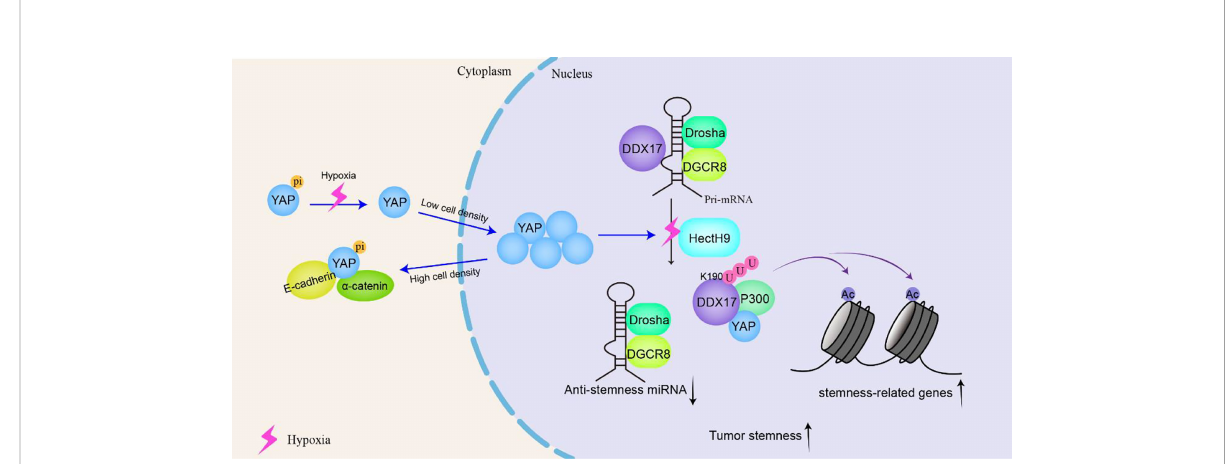
FIGURE 6 DDX17 participates in the YAP signaling pathway to increase the stemness of cancer stem-like cells and to promote tumorigenesis and tumor progression. In tumor cells, that is, at low density, YAP is located in the nucleus and serves as a transcription-assisted activator to promote cell proliferation. Under hypoxic conditions, K190 on DDX17 undergoes K63 ubiquitination by the E3 ligase HectH9. YAP binds to and isolates ubiquitinated DDX17, dissociating it from the Drosha-DGCR8 complex to block the biosynthesis of antitumor stem microRNAs (miRNAs). Meanwhile, ubiquitinated DDX17 forms a YAP-DDX17-p300 complex, leading to the acetylation of histone 3 lysine 56 (H3K56) to activate cancer-related gene transcription, resulting in increased stemness of cancer stem-like